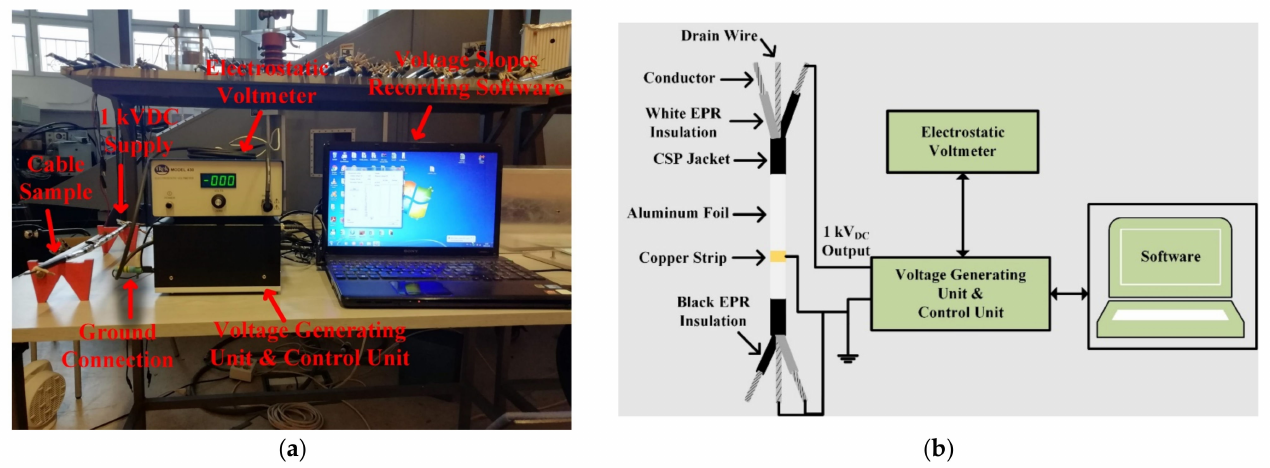
Figure 3. Extended voltage response (EVR) measurement: ( a ) setup and ( b ) connection diagram.